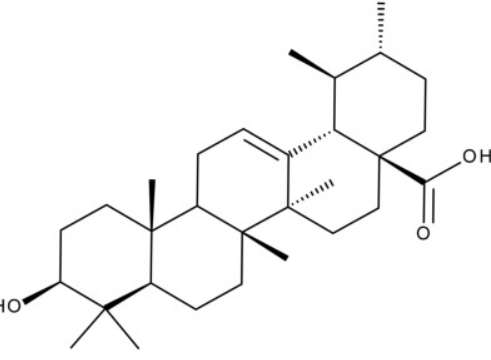
Figure 22. Chemical structure of ursolic